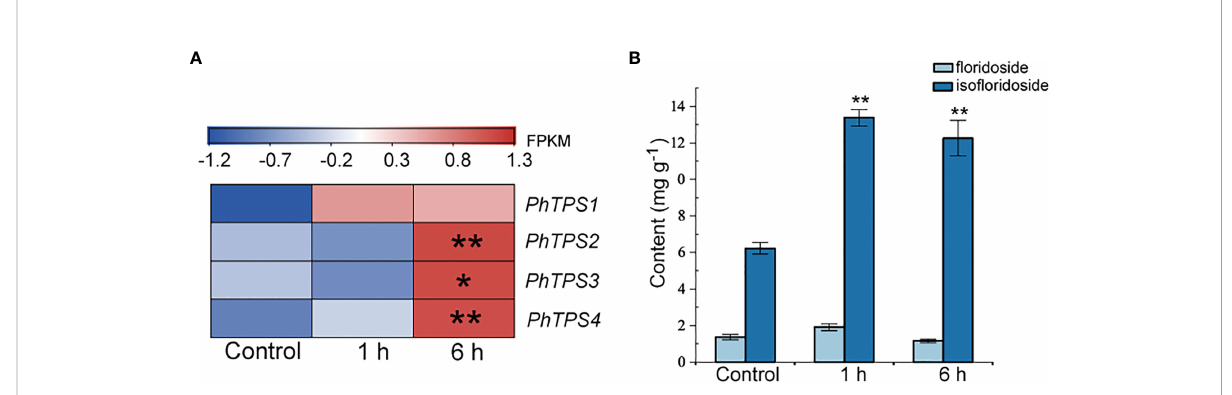
FIGURE 5 Effect of exogenous abscisic acid (ABA) on the expression of PhTPS1-4 (A) , and on the content of fl oridoside and iso fl oridoside (B) in Neoporphyra haitanensis . The thalli were treated with 100 m M ABA for 1 or 6 hours. FPKM values of expressed genes in different groups were used to construct the heatmaps after a z-score normalization (n = 3). * P < 0.05, ** P < 0.01 when compared to control group.